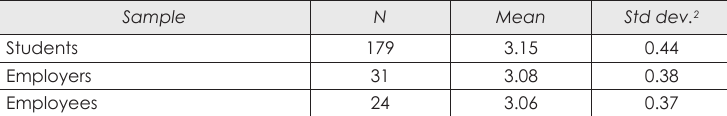
Table 19: Comparison of aggregated